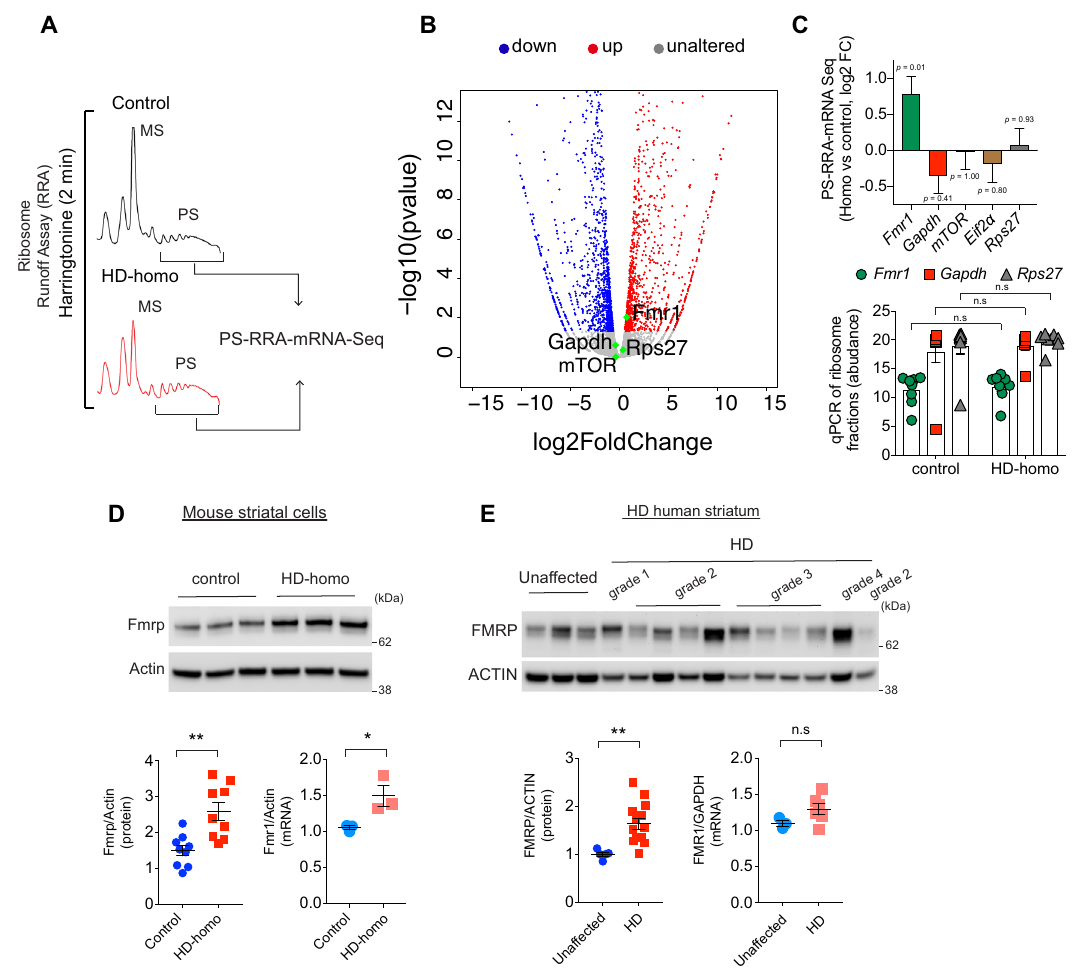
Fig. 4 Fmrp is upregulated in HD. A Representative polysome pro fi les of control and HD-homo cells after ribosome run-off assay using Harringtonine (2 µ g/ml, 2min). mRNA-Seq was performed using RNAs isolated from polysome containing fractions (arrows). B Volcano plot representing changes in gene expression levels of ribosome-bound mRNAs in HD-homo cells (vs control cells) after ribosome run-off assay from A . mRNA transcripts with absolute log2 fold change (log2FC) >0.3 and FDR-corrected P value <0.05 are shown with red (up, increased polysome binding, log2FC>1), blue (down, decreased polysome binding, log2FC< 1), gray (unaltered, no difference in polysome binding) and green (selected targets). Statistical testing was done using DESeq2 with a two-tailed Wald test and adjusted for multiple comparisons using the procedure of Benjamini – Hochberg. C A bar plot representing log2FC in the mRNA levels of some known translation regulating genes within polysome fractions obtained from HD-homo cells (comparing to controls) after ribosome run-off assay (upper panel, Data are log2FC and the standard error of the log2FC value from n = 2 independent experiments), and qPCR of the indicated targets in the puri fi ed ribosome fractions (bottom panel, Data are mean± SEM, n = 8 independent experiments, n.s. not signi fi cant by two-way ANOVA, Bonferroni ’ s multiple comparisons test). D , E Representative blots and mRNA levels and corresponding quanti fi cations for Fmrp in mouse control and HD- homo striatal cells (Fmrp protein: n = 9 independent experiments, Fmrp mRNA: n = 3 independent experiments, D ), and unaffected and human HD patient striatum (Fmrp protein: n = 5 unaffected, n = 14 HD, FMRP mRNA: n = 3 unaffected, n = 6 HD, E ). Data are mean ± SEM, * P < 0.05, ** P <0.01 by two-tailed Student ’ s t test, n.s not signi fi cant. Exact P values are reported in the Source Data fi le. Source data are provided as a Source Data fi